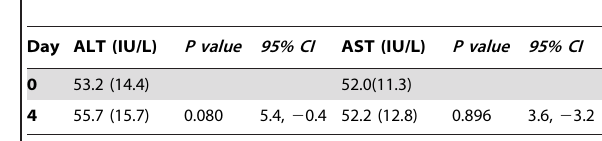
Table 9. Effects of Prednisone on liver injury indicators.